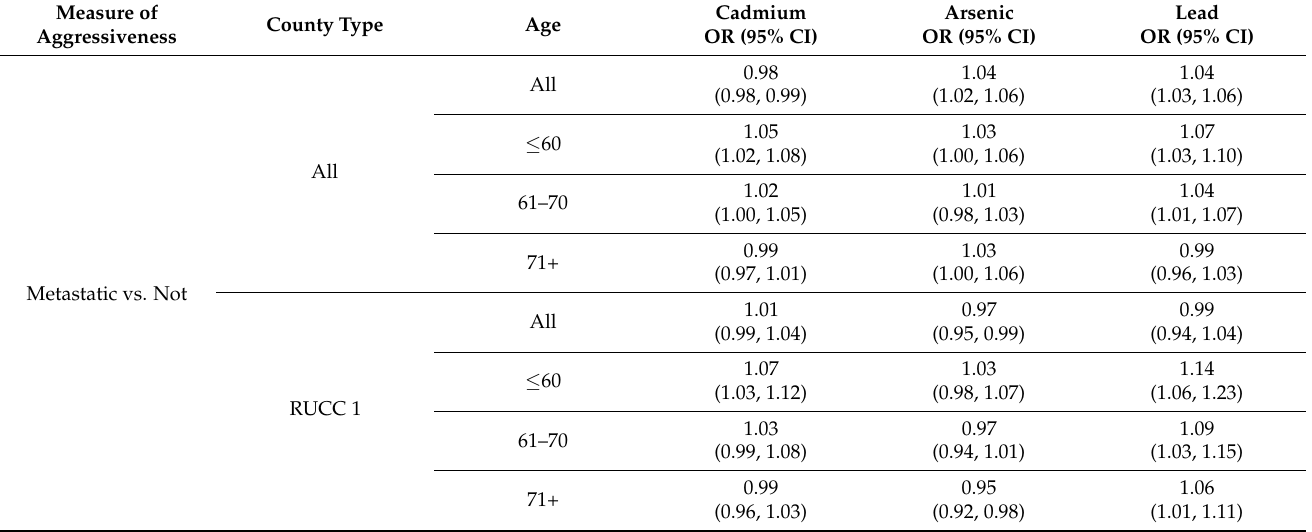
Metastatic vs. Not